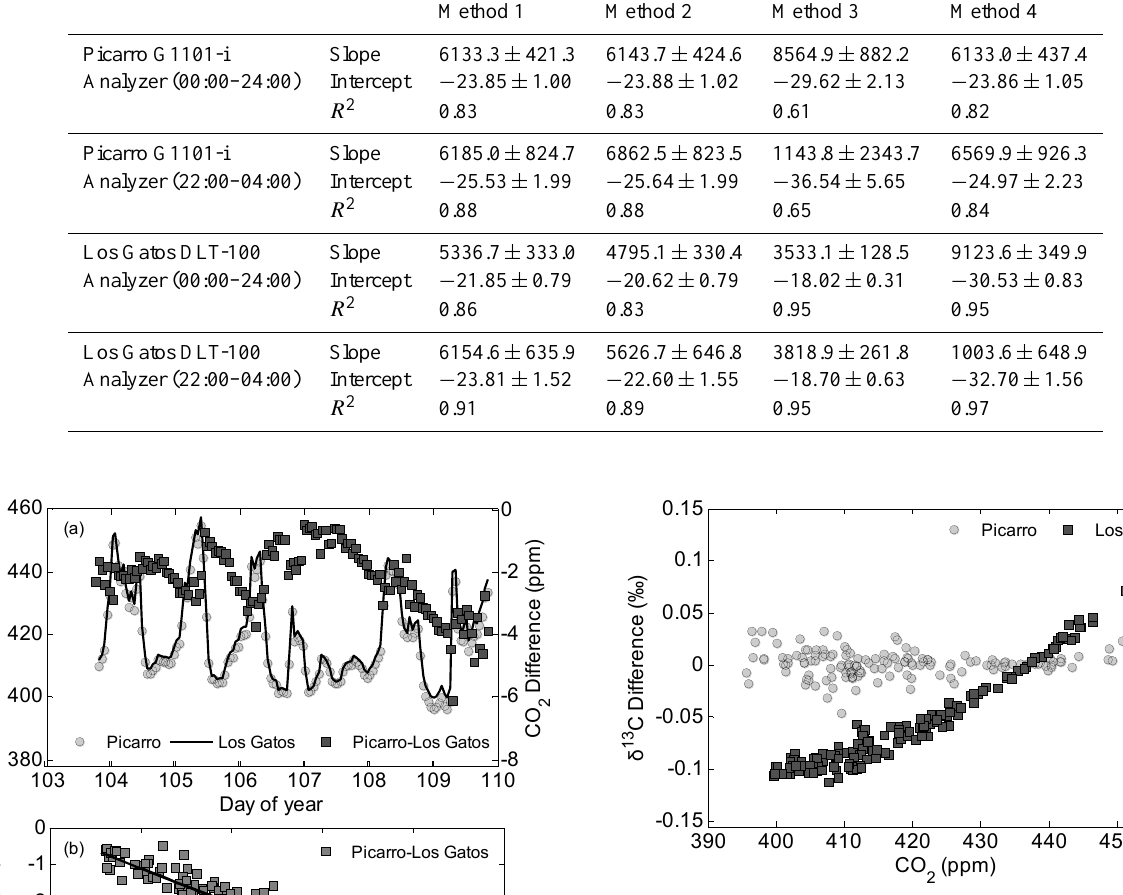
Fig. 4. Dependence of the difference in atmospheric δ 13 C between Method 1 and Method 2 on the CO 2